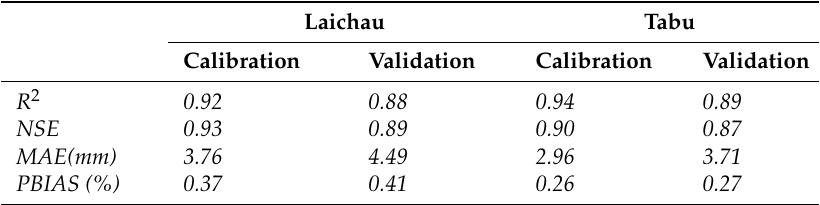
Table 2. Evaluation of model simulation during the pre-change period for the catchments controlled by Laichau and Tabu stations in the Da River Basin